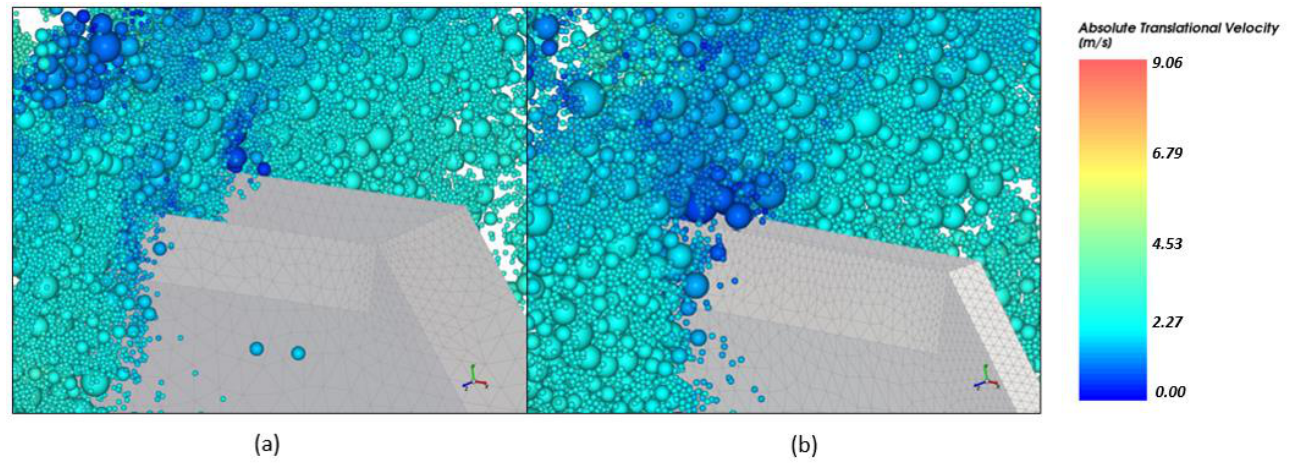
Figure 7. Close up view of the cutter in operation in two diferent DEM simulations. Particles’ velocity in cutter’s top: dark blue low velocity and light blue high velocity. ( a ) Simulation 05: 4D; ( b ) Simulation 01: 1D.